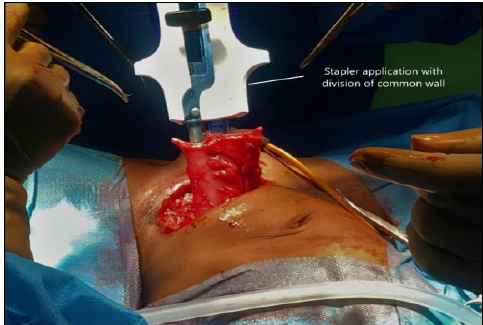
Figure 2: Showing unification of two normal and duplicated colons with the help of GIA linear cutter. At 1 year of age, the baby was booked for the definitive procedure. Sigmoid stoma was mobilized. The common wall between the duplicating segments was divided using a 75mm linear cutting stapler (Ethicon) (Fig.2). Distal Hartmann's stump was mobilized and end to end anastomosis was completed. Both appendices were